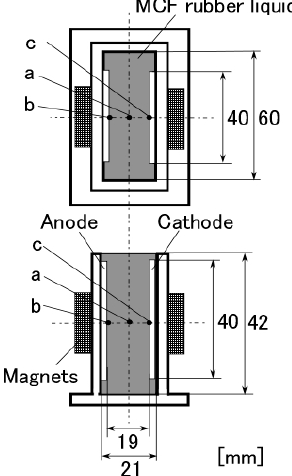
Figure 1. Schematic diagram of experimental apparatus used to investigate the effect of magnetic field distribution and magnitude on the solidification of MCF rubber liquid by the NM.